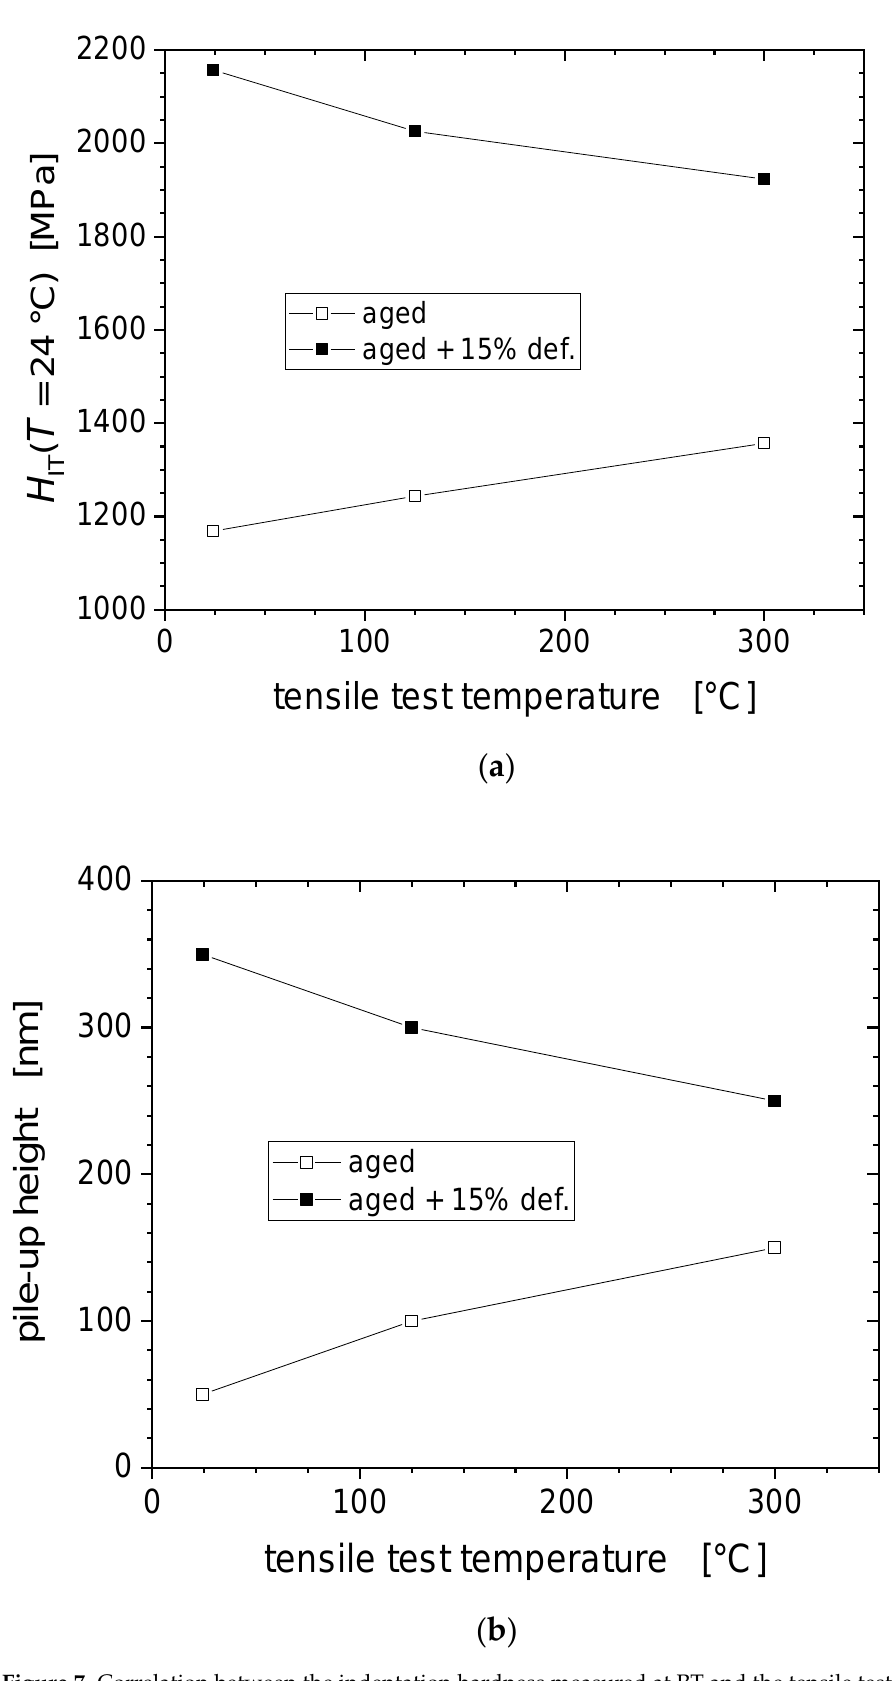
Figure 7. Correlation between the indentation hardness measured at RT and the tensile test temperature ( a ), and between pile-up effect and tensile test temperature ( b ).